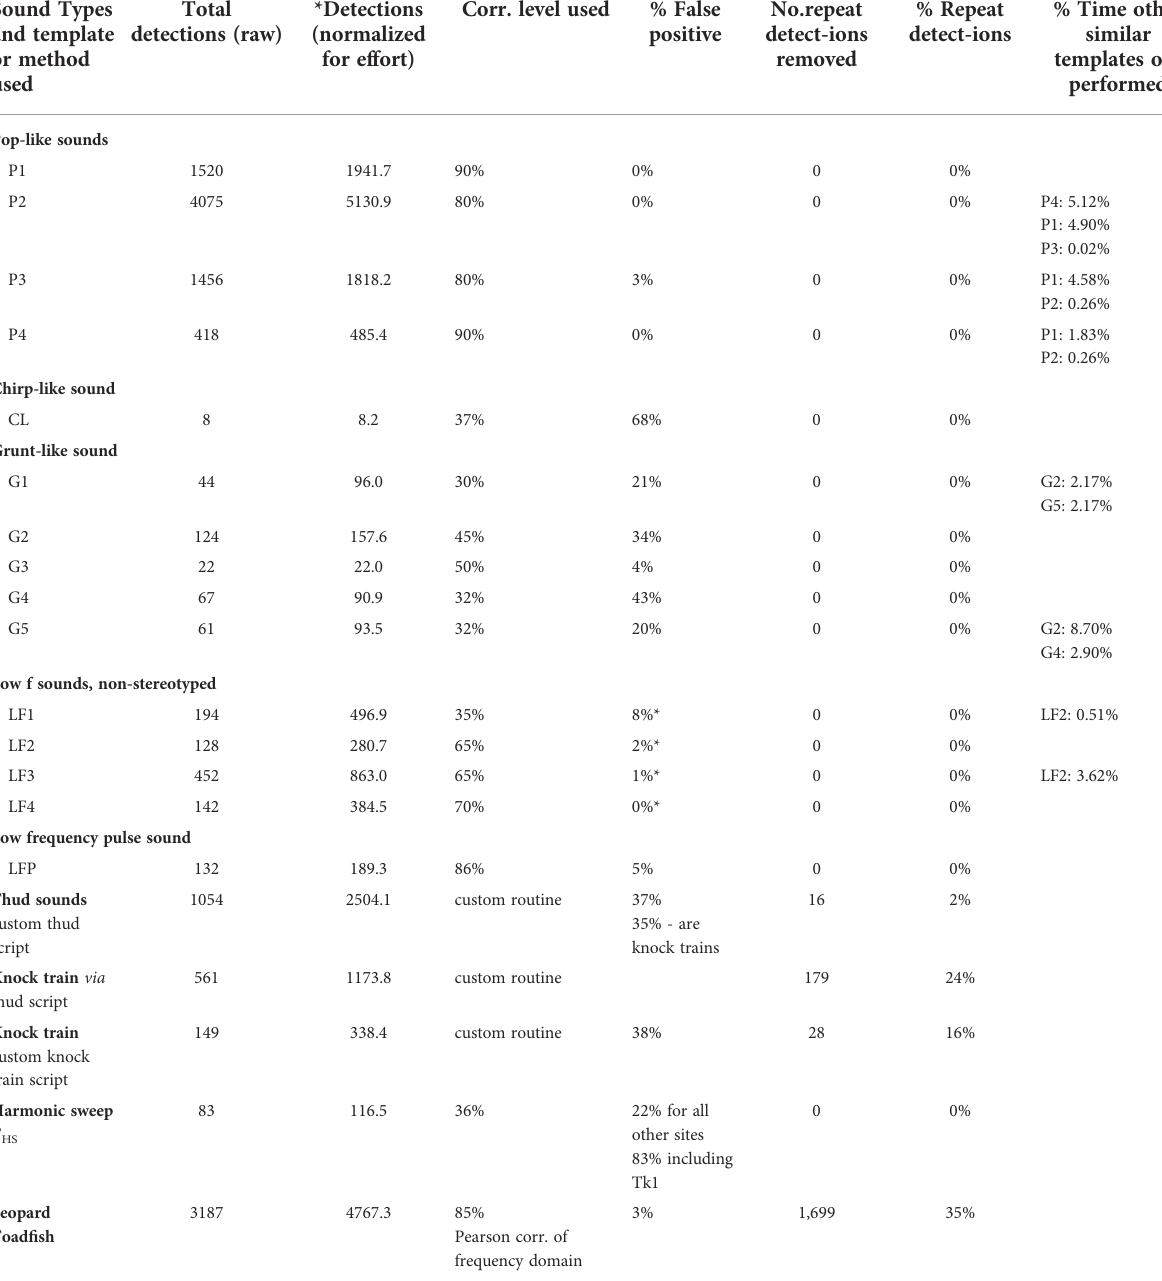
TABLE 1 Sound types and detection method, number of detections, normalized detections, correlation level used, false positive rate, repeat detections, repeat detection rate, and performance relative to similar detection methods. Sound Types and